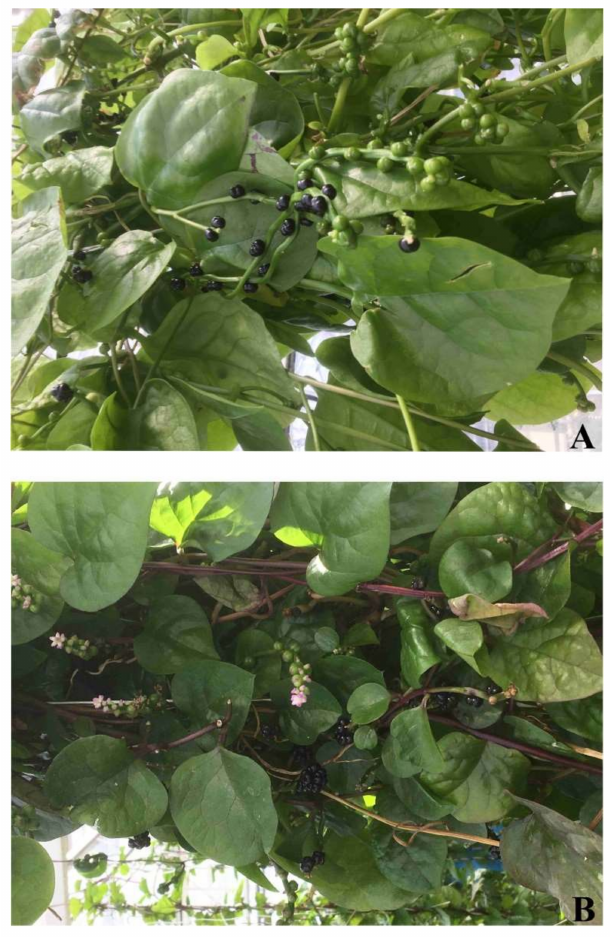
Figure 1. A photograph of grown B. alba ( A ) and B. alba var. ‘Rubra’ ( B ) plants. Betalains are a group of water-soluble colored compounds containing nitrogen in their structure (Figure 2) [7,9]. They occur in most plants of the order Caryophyllales [10], and they were also found in some species of fungi of the genera Amanita and Hygrocybe [11,12]. These compounds consist of betalamic acid as the chromophore core that condenses with cyclo -DOPA or amino acids/amines to form red-violet betacyanins and yellow-orange betaxanthins, respectively. Gomphrenins, classified as betacyanins [7], are characterized by a hydroxyl group attached to the C-5 carbon and a glucose linked at the C-6 position [13]. Betacyanins found in plant extracts are usually accompanied by their respective isoforms (isobetacyanins). The reason for isomerization may be factors induced by the environment, e.g., postharvest change of reaction pH, as well as thermal